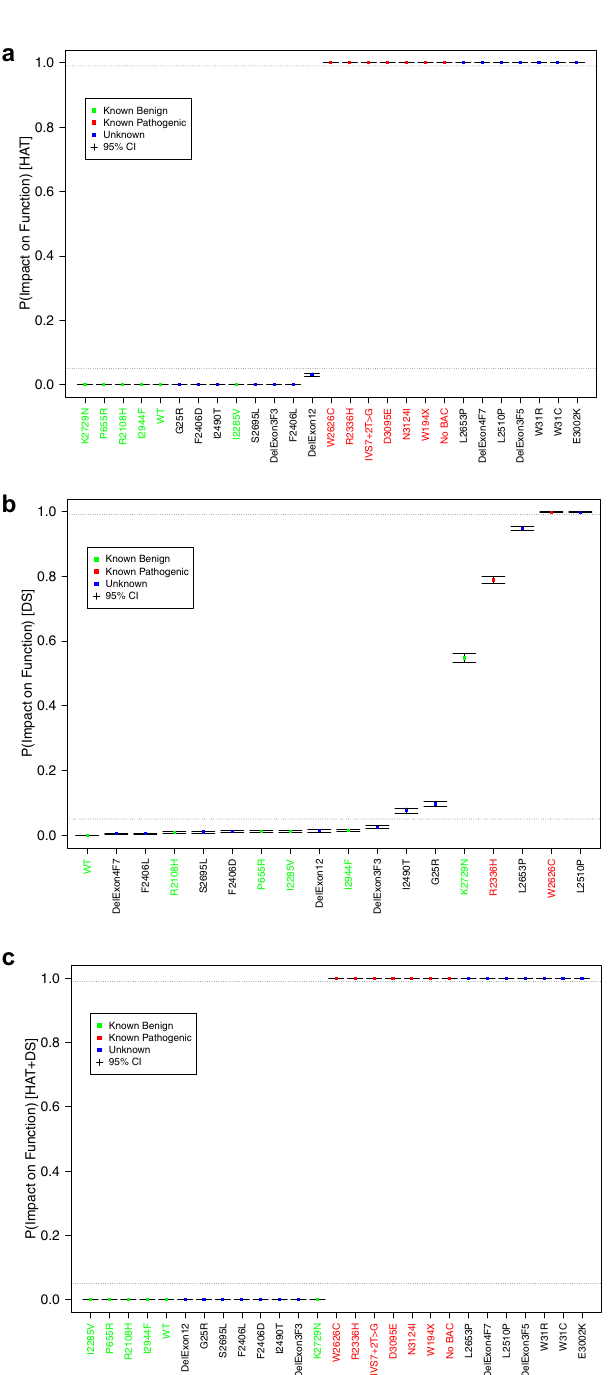
Fig. 5 Classi fi cation of variants using combined data of drug sensitivity assay and cell survival. Boxplots of the PIFs estimated for the validation set variants, plotted in increasing order. a Based on HAT model, b based on the DS model, and c based on the HAT + DS model. Note that variant del exon 4 – 7 is estimated to be neutral based on the HAT data and pathogenic based on the drug sensitivity assay. It remains unclassi fi ed when the data are